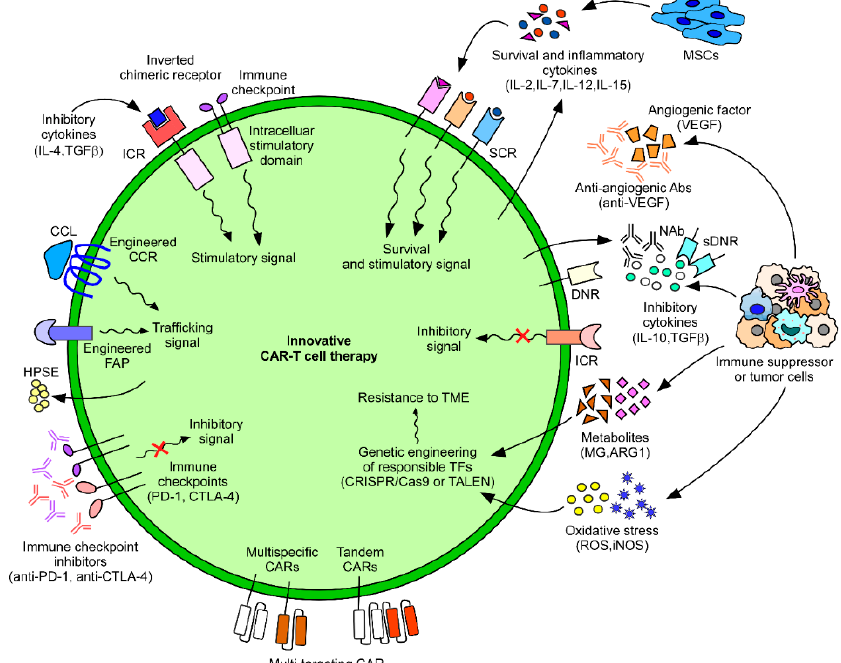
Figure 2. Approaches for improved CAR-T cell therapy. Innovative approaches of CAR-T cell therapy for solid tumors. Inverted chimeric receptors convert the inhibitory signals from cytokines (IL-4 or TGF β ) or immune checkpoint to stimulatory one via intracellular stimulatory domain. Engineered expression of cognate chemokine receptors (CCRs) with matching of chemokines (CCL), fibroblast activated protein (FAP), and heparanase (HPSE) induces trafficking signals and T cell infiltration into tumor microenvironment (TME). As immune checkpoints, such as PD-1 or CTLA-4, suppress T cell activation, blocking their signals with immune checkpoint inhibitors (anti-PD-1 or anti-CTLA-4) enhances CAR-T cell cytotoxicity. Multi-specific CARs and tandem CARs target multiple tumor antigens to boost its function. Genetic engineering of responsible transcription factors (TFs) to regulatory signals of oxidative stress (ROS and iNOS) and immunosuppressive metabolites (MG and ARG1), from either tumor cells or immune suppressor cells, provides CAR-T cells the resistance to TME. NAbs or sDNR against inhibitory cytokines, such as IL-10 and TGF β , prevent inhibitory signals via inhibitory cytokine receptors (ICR). Anti-angiogenic antibodies (anti-vascular endothelial growth factor (VEGF)) block angiogenesis and then improve T cell infiltration into the tumor bed. MSCs or CAR-T cells engineered to express survival or inflammatory cytokines, IL-2, IL-12, IL-7, and IL-15, enhance T cells function and maintenance. Combinations of these approaches in a solid tumor models enhance T cell cytotoxicity. CR: cytokine receptor, iNOS: inducible nitric oxide synthase, sDNR: soluble dominant negative receptors, NAb: neutralizing antibody, ICR; inhibitory cytokine receptor, SCR: stimulatory cytokine receptor, MSCs: mesenchymal stem